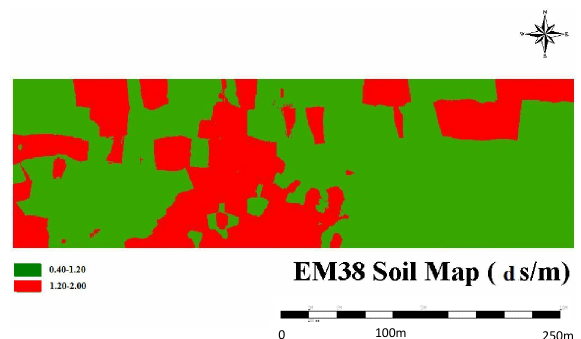
Fig. 3. EM 38 soil map of Veale Gardens showing lysimeter posi-